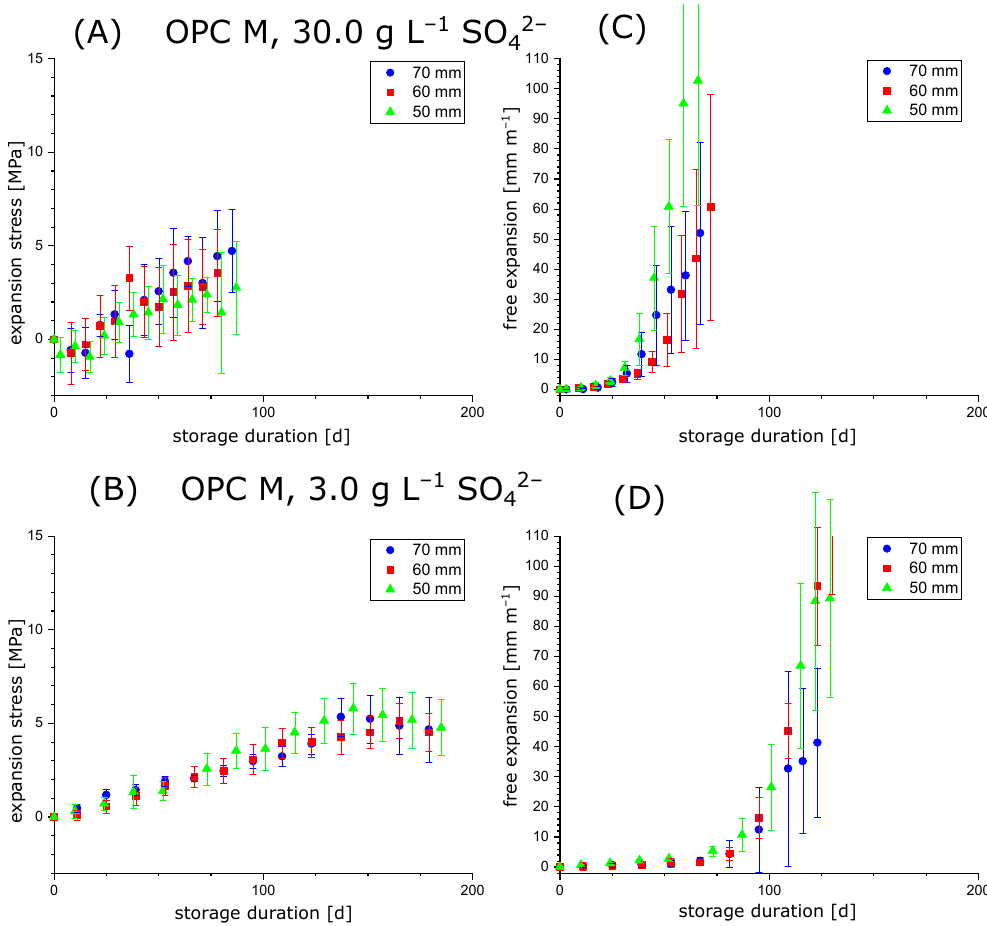
Figure 6. Expansion experiments (sodium sulphate solution, 30.0gL SO 2– 4 or 3.0gL SO 2– 4 ) for hollow cylinders with varying diameter/length ratios prepared with OPC M. The samples were stored until their mechanical failure due to the formation of macroscopic cracks. ( A , B ) Expansion stress (stress cell with steel rod). ( C , D ) Free expansion (stress cell with steel